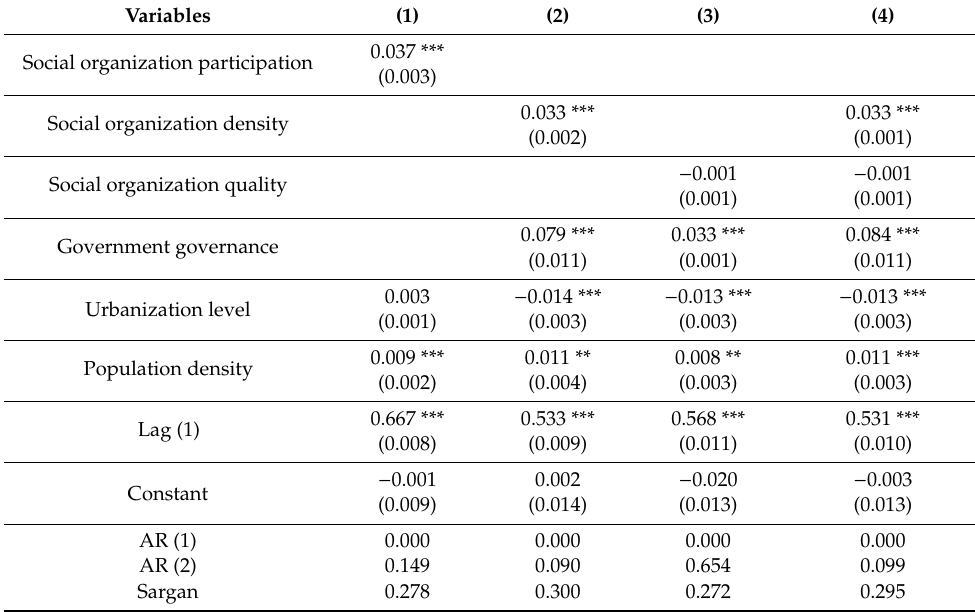
Table 5. Social organization participation decomposition